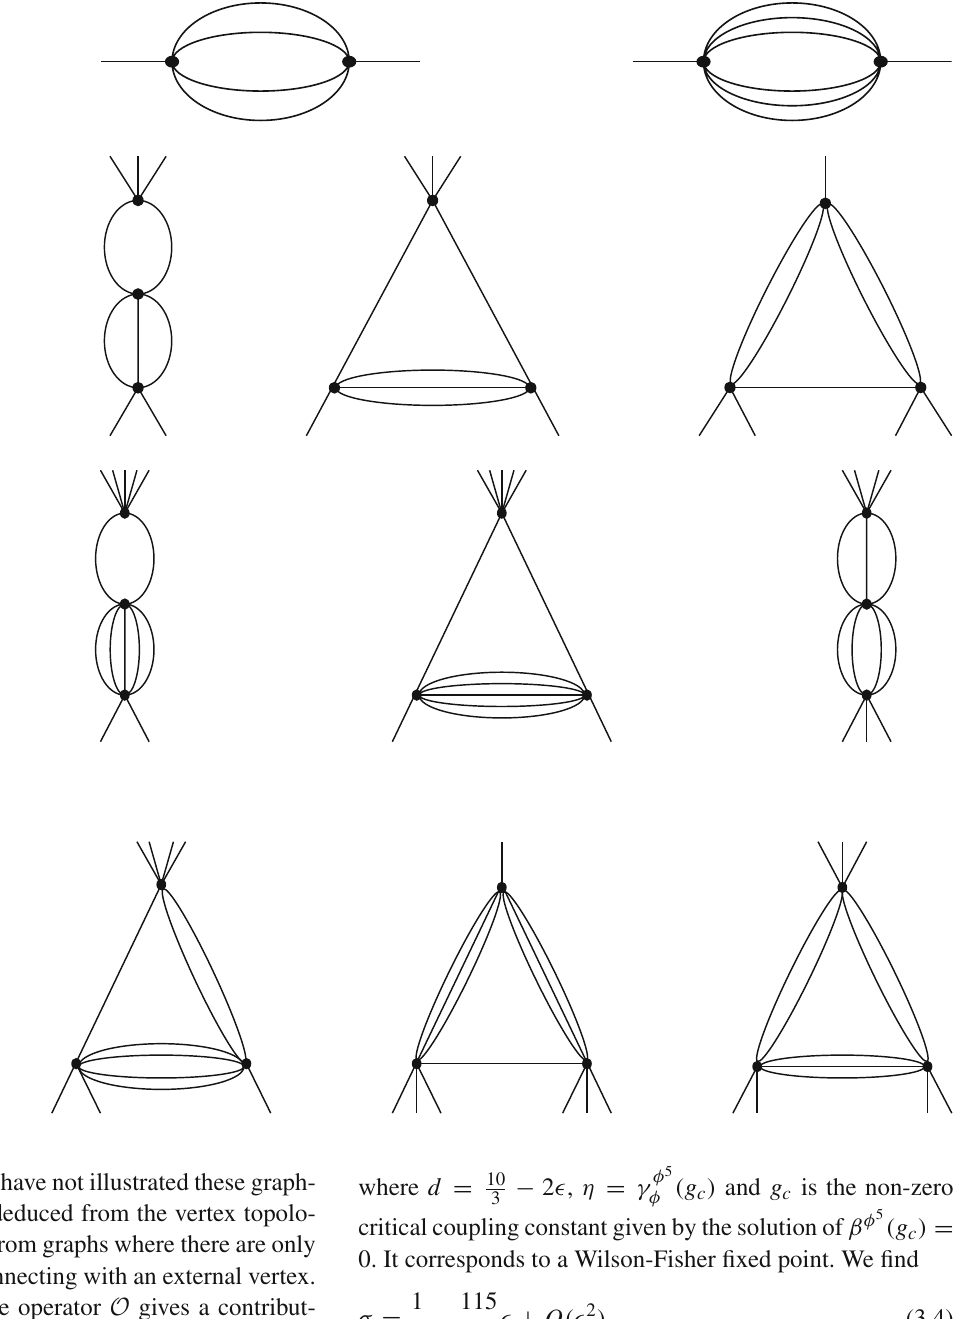
topologies for 2-point functions in φ 5 and φ 7 scalar theories